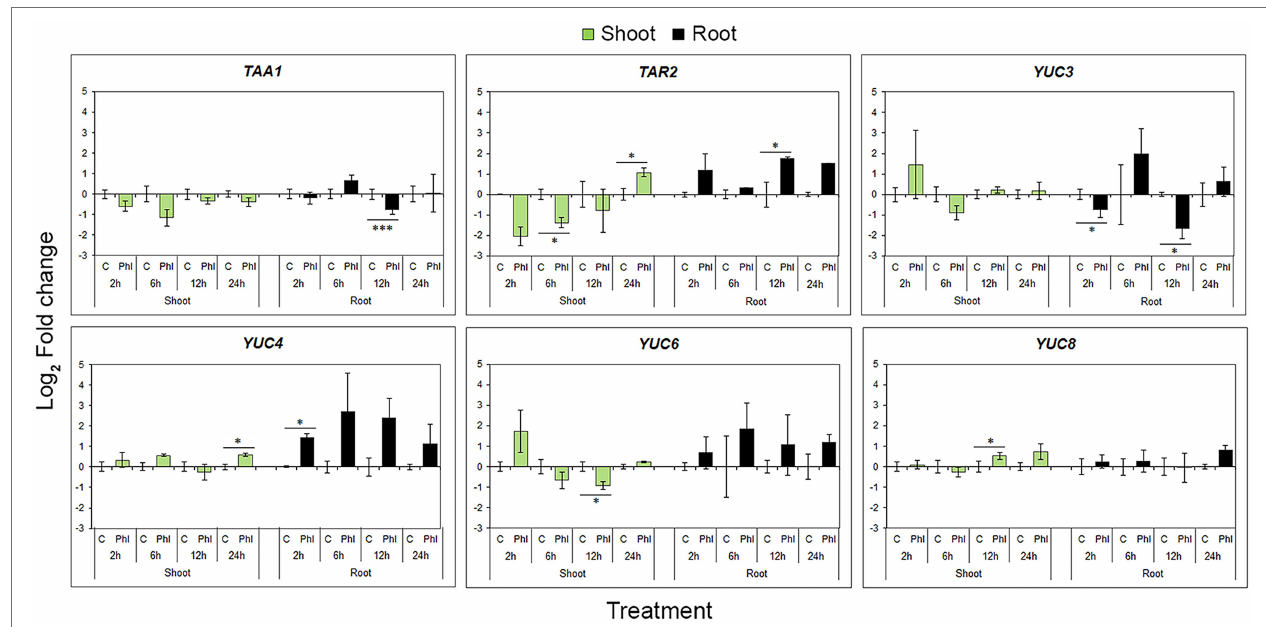
FIGURE 7 | Effect of phloretin on the expression of genes involved in the auxin IPyA biosynthetic pathway in Arabidopsis. Expression levels of TAA1, TAR2, YUC3, YUC4, YUC6 and YUC8 genes in Arabidopsis [ Arabidopsis thaliana (L.) Heynh.] Col-0 shoots and roots at 2, 6, 12 and 24 h of treatment with 500 μ M phloretin. Expression levels were calculated relative to an expression of corresponding control according to the ΔΔ Ct method and presented as log 2 transformation of fold changes. Values are presented as means ±SE from three biological replicates (samples from three independent experiments). Asterisks indicate statistically significant difference at * p < 0.1 and *** p < 0.01 based on Student’s t